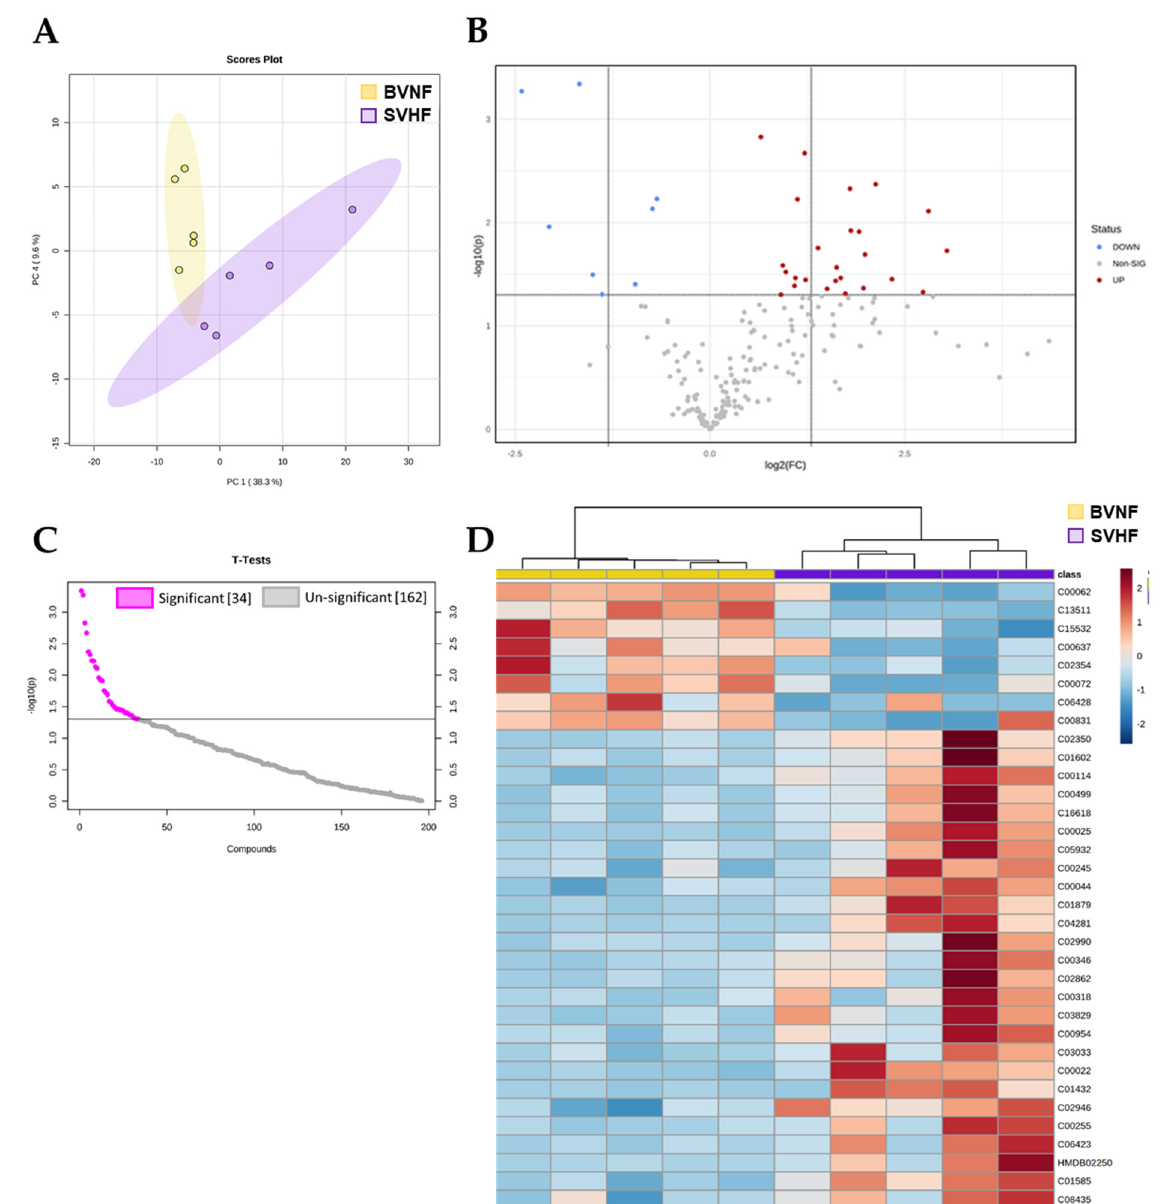
Figure 3. SVHF serum elicited significant metabolite changes compared to BVNF serum. ( A ) Dendrogram of metabolites separated between BVNF ( n = 5) and SVNF ( n = 5) serum samples. ( B ) Volcano plot representation of all the 196 metabolites detected by mass spectrometry as the log2 fold-changes in expression ( x -axis) and the log odds of a gene being differentially expressed ( y -axis), highlighting the 34 metabolites that were significantly differentially expressed between BVNF versus SVHF sera (above dotted line). ( C ) Significant and non-significant changes in serum metabolite expression in SVHF vs. BVNF. ( D ) Heat map of the 34 significant metabolites. Unsupervised hierarchical clustering separated BVNF ( n = 5) and SVHF ( n = 5) serum samples. Each sample is represented by a single column. The higher the intensity of the red color, the higher the abundance of the metabolite .